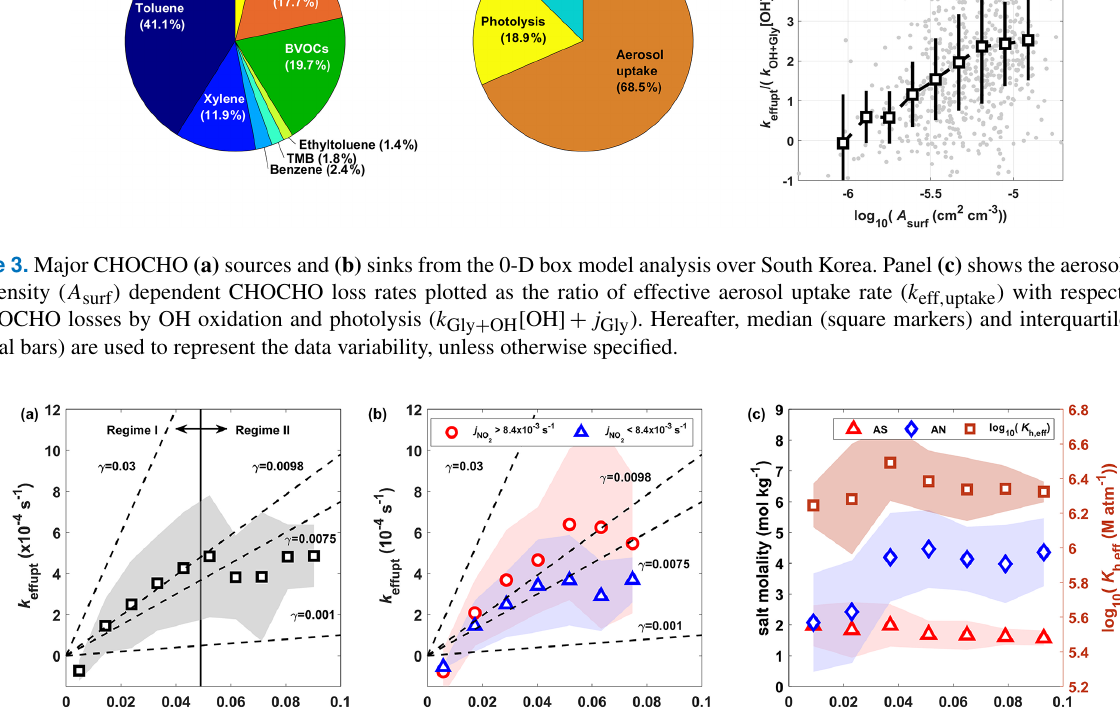
Figure 4. The (1 / 4 · v GLY · A surf ) dependence of (a) k eff , uptake , (b) higher (red) and lower (blue) j NO 10 − 3 s − 1 ), and (c) ammonium sulfate (AS) and ammonium nitrate (AN) molality, and the effective Henry’s law constant, K H , eff_Gly , parameterized with AS and AN molalities. Dashed black lines in (a) and (b) are a few examples of the uptake coefficient, γ . Shaded areas represent interquartile